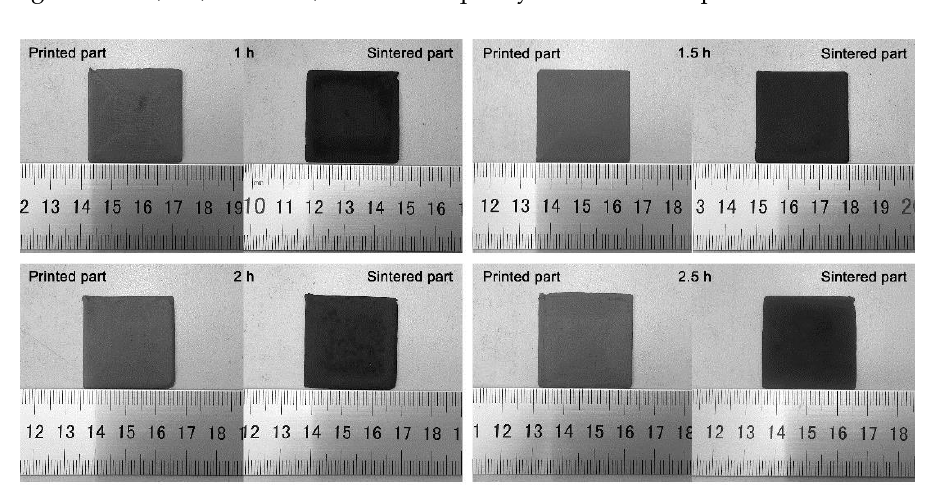
Figure 10. Comparison of printed parts before and after sintering for different holding times.